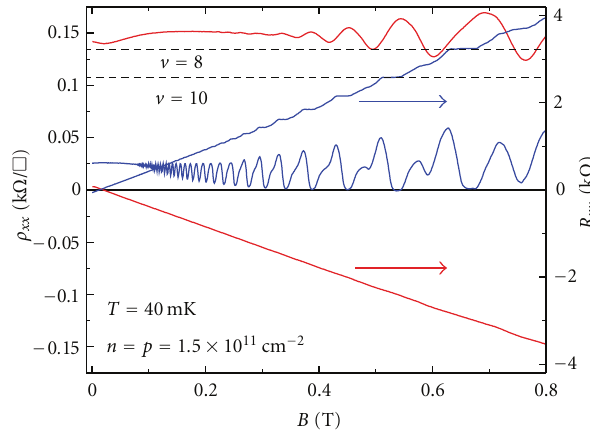
Figure 6: 2DEG and 2DHG in an EHBL made by the method described in [23, 26, 31] (Cavendish